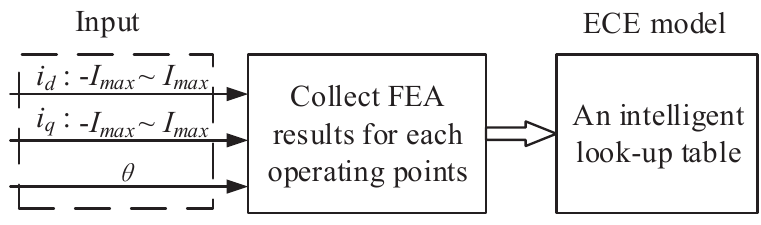
Figure 5. Flowchart of the setup of the equivalent circuit extraction (ECE) motor